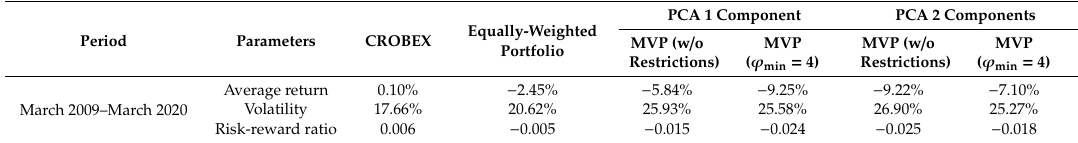
Table 5. Out-of-sample performance of the estimated MVP using “fundamentally-weighted” returns as inputs for